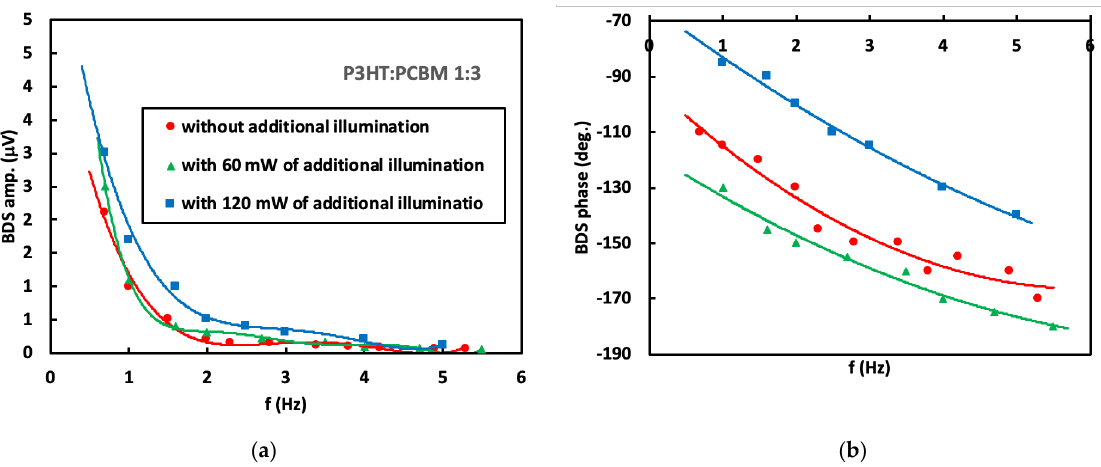
Figure 4. ( a ) Amplitude and ( b ) phase of BDS signal dependence on modulation frequency of TOs for P3HT:PCBM (1:3).